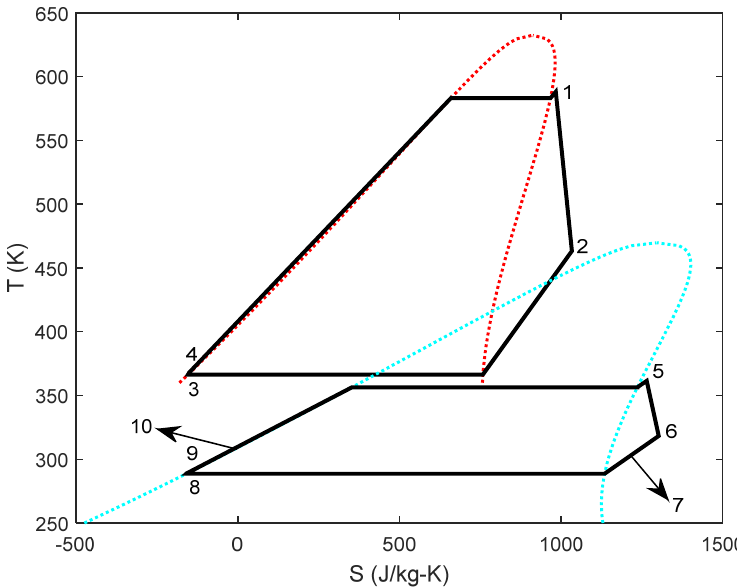
Figure 2. Temperature-entropy diagram of cascading ORC-WHS.